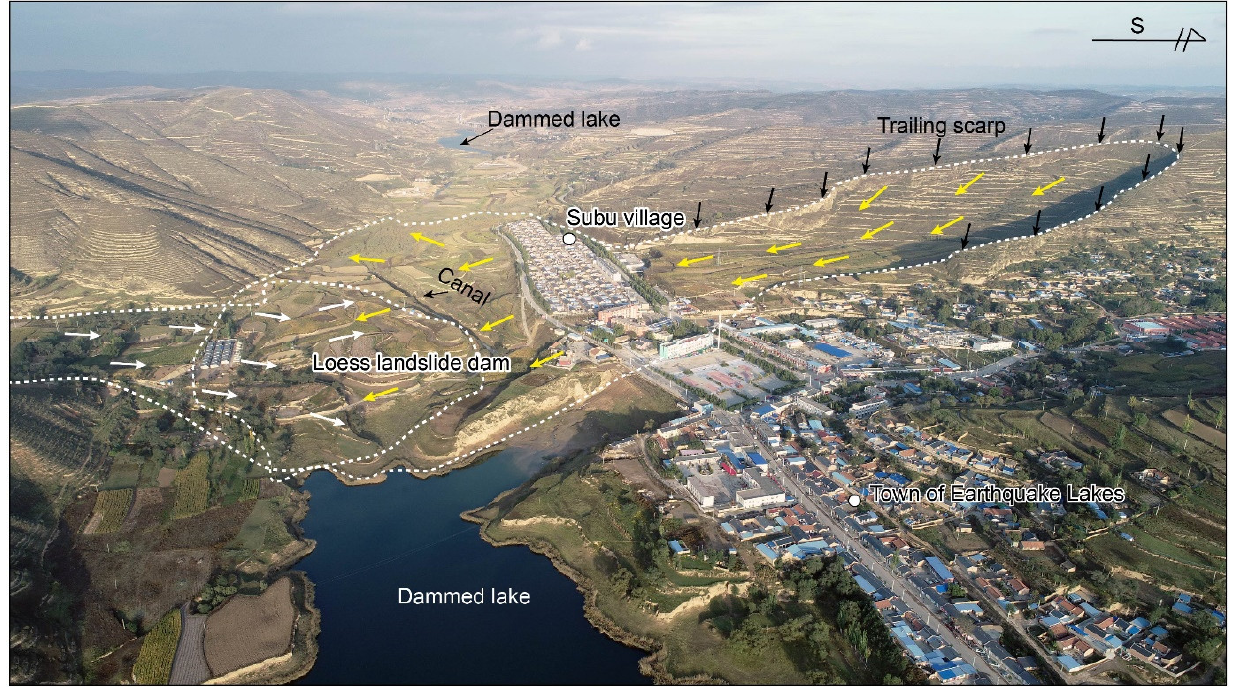
Figure 12. Damming landslide at Subao village (No. 5 landslide dam in Figure 7). The loess landslide dam surface is uneven. Local people build houses and canals on the loess landslide dam for living and farming on the original landslide dam with slight reconstruction measures.